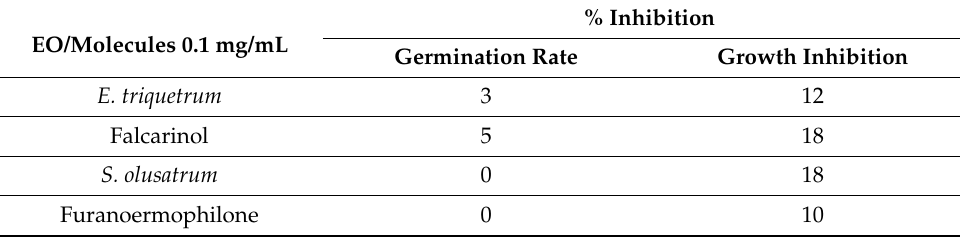
Table 4. Germination and growth inhibition results of E. triquetrum and S. olusatrum essential oils and the major